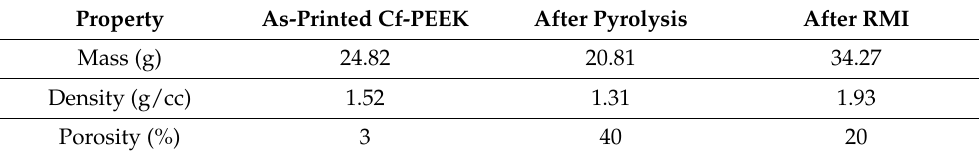
Table 1. Information on preforms, pyrolyzed samples, and MI samples.